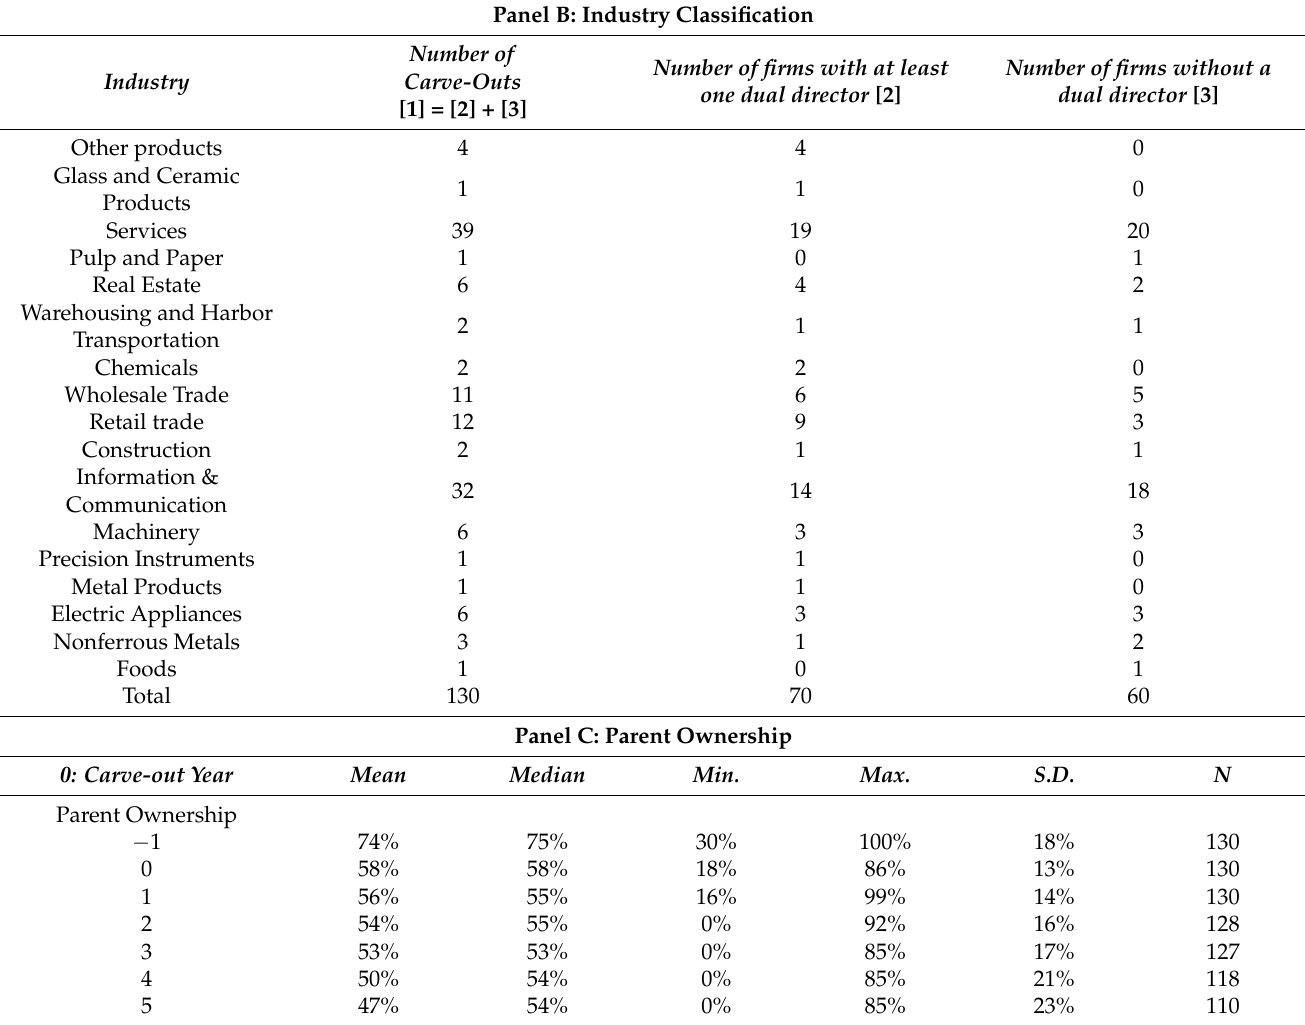
Table 1. Cont. Panel B: Industry